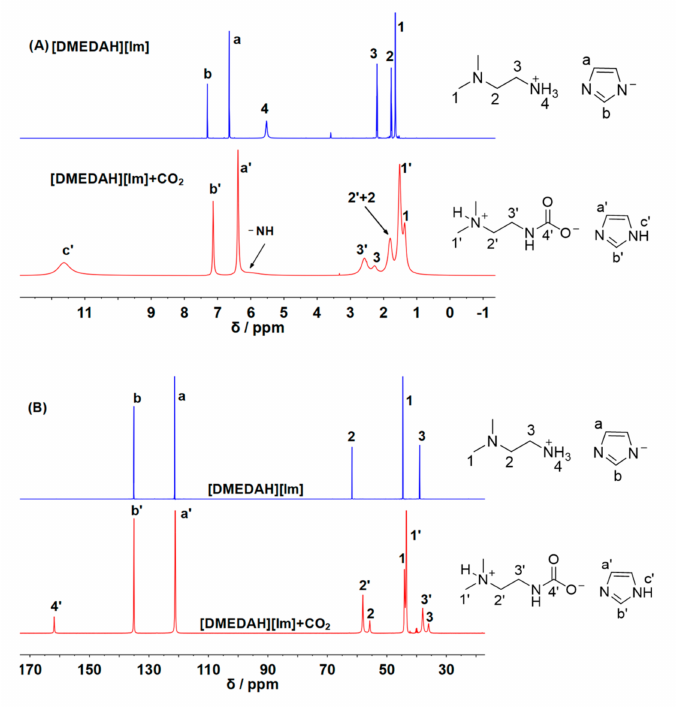
Figure 1. Spectra of 1 H ( A ) and 13 C ( B ) NMR of [DMEDAH] [Im] with and without CO 2 ; DMSO- d 6 was used as an external